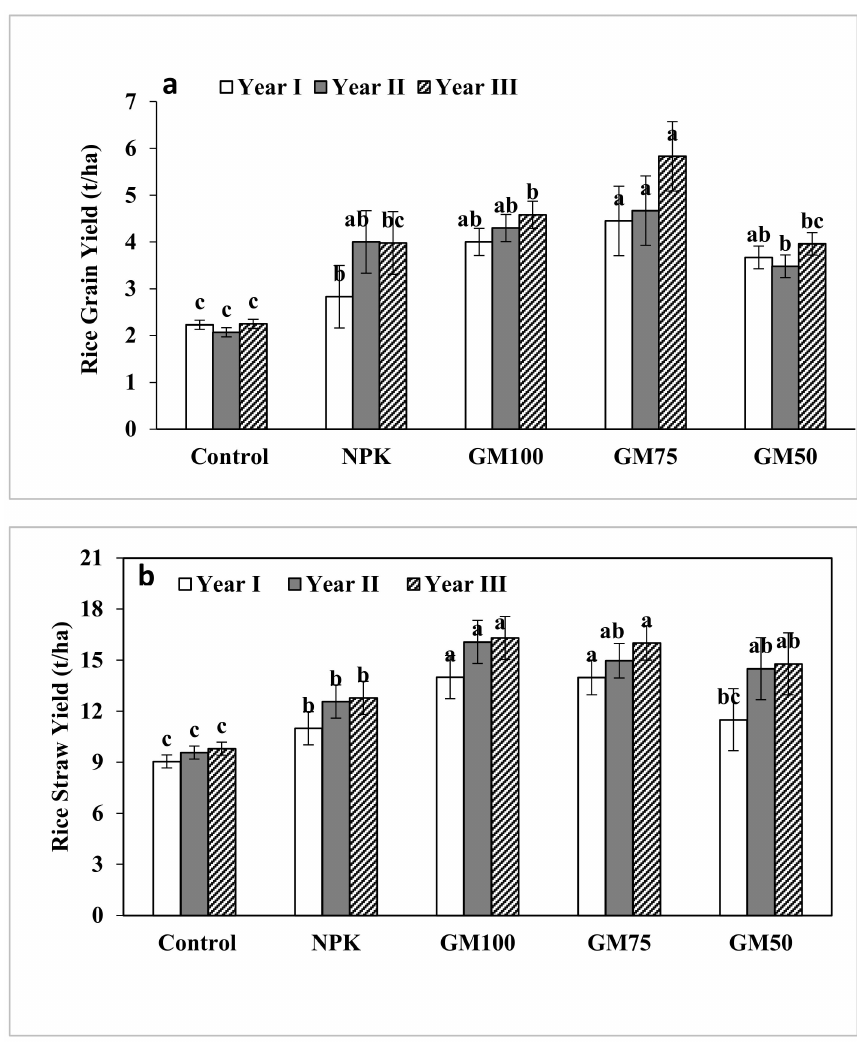
Figure 1. Effect of green manuring on rice grain ( a ) and straw yields ( b ). Control (without any chemical or green manuring amendment), NPK (No Green manuring, 100% recommended nitrogen, phosphorus, and potassium-NPK), GM 100 (green manuring + 100% recommended NPK), GM 75 (green manuring + 75% recommended NPK), and GM 50 (green manuring + 50% recommended NPK). Blank column shows first year, grey filled second year, and pattern filled shows third year data. Columns sharing the same letters are not significantly different at p ≤ 0.05 probability